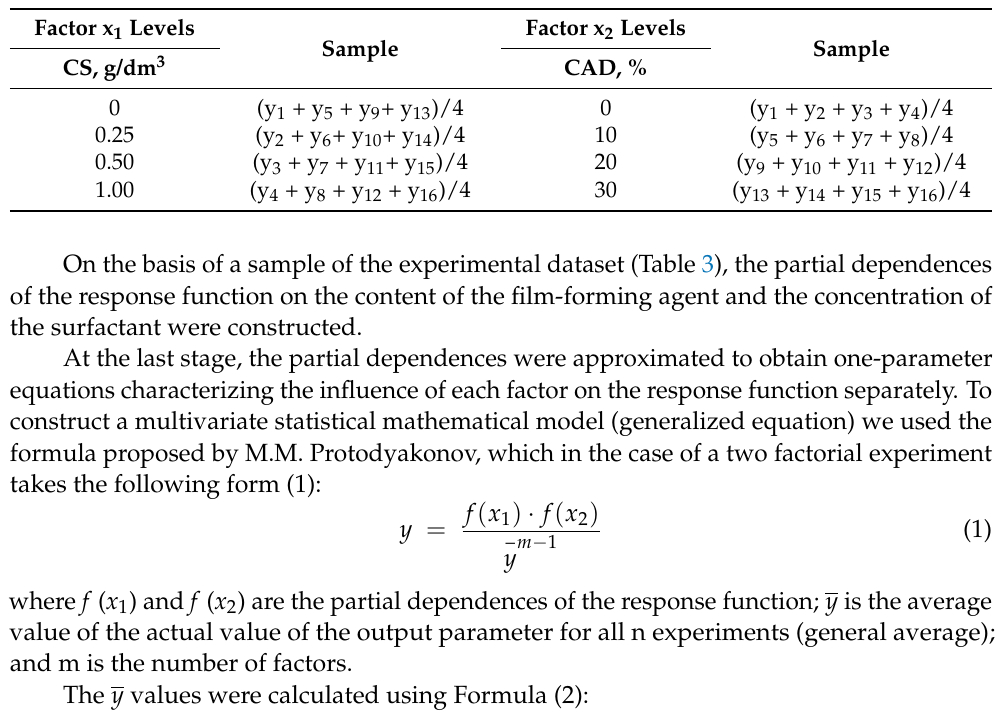
Factor x 2 Sample